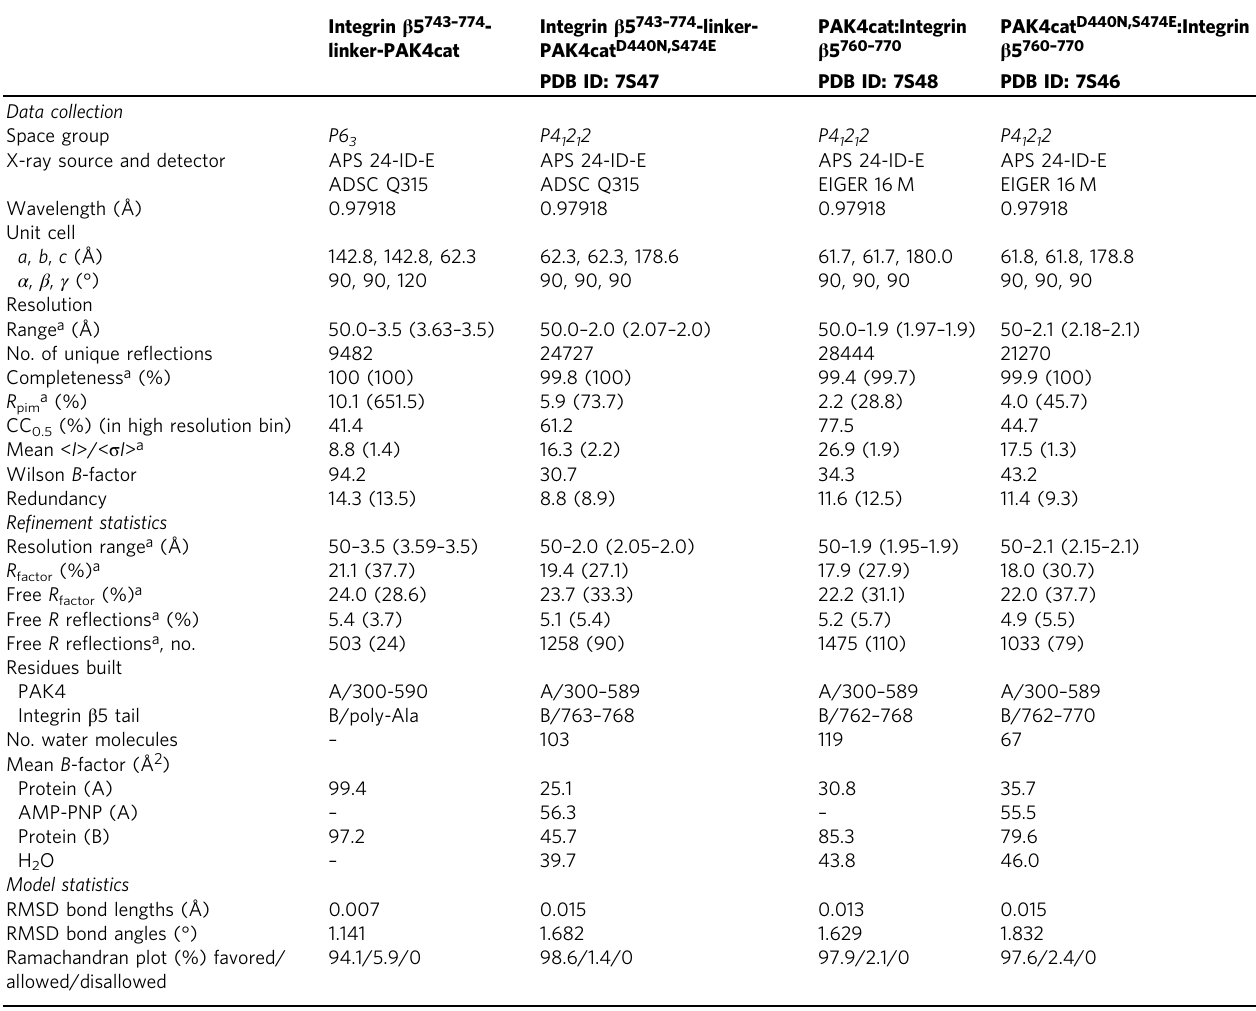
Table 1 Data collection and re fi nement